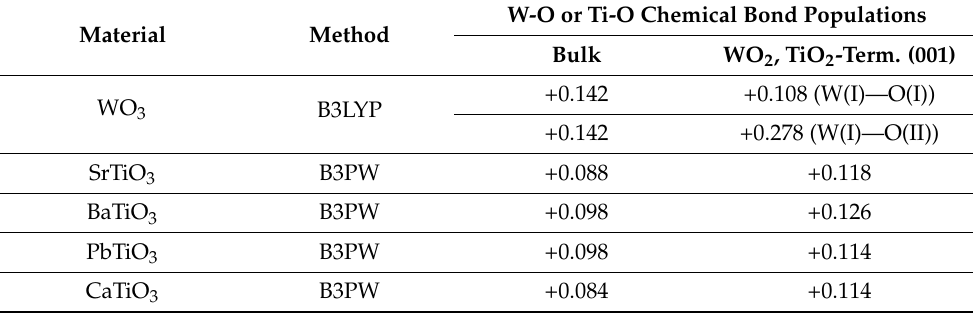
Table 8. Our B3LYP or B3PW calculated W–O or Ti–O chemical bond populations for WO 3 , SrTiO 3 , BaTiO 3 , PbTiO 3 and CaTiO 3 bulk and for WO 2 - or TiO 2 -terminated (001) surfaces (in e